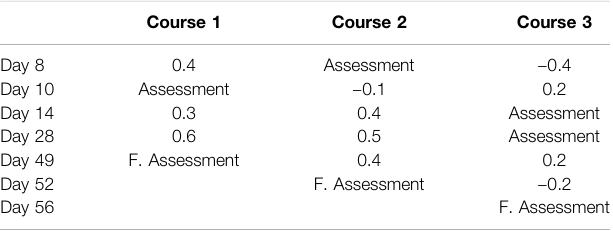
TABLE 2 | Effect sizes difference of online engagement in one course, when an assessment is due in